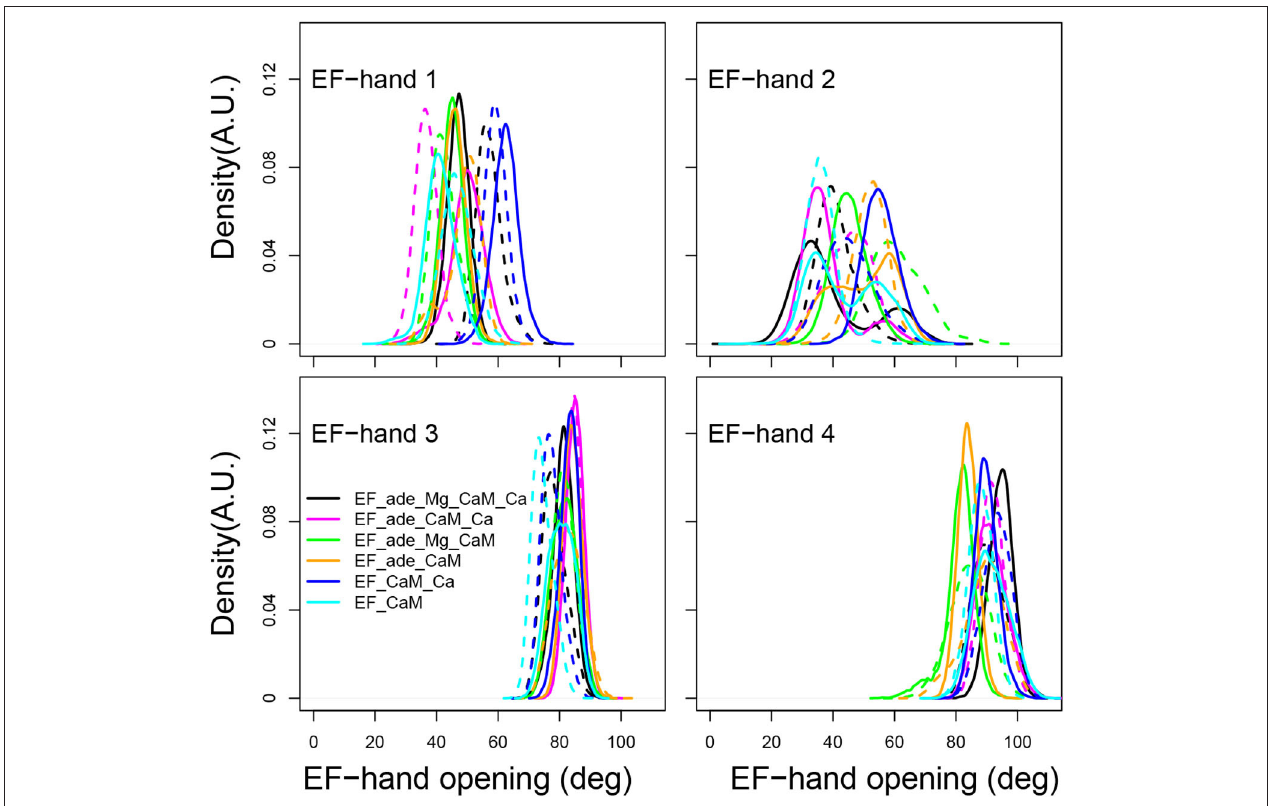
FIGURE 6 | Angle of the EF-hands (deg) calculated between axes of α helices including residues 8-19 (helix I), 31-37 (helix II), 46-53 (helix III), 66-73 (helix IV), 83-92 (helix V), 103-110 (helix VI), 119-127 (helix VII), 139-145 (helix VIII). The angle of EF-hand 1 is the angle between helices I and II. The angle of EF-hand 2 is the angle between helices III and IV. The angle of EF-hand 3 is the angle between helices V and VI. The angle of EF-hand 4 is the angle between helices VII and